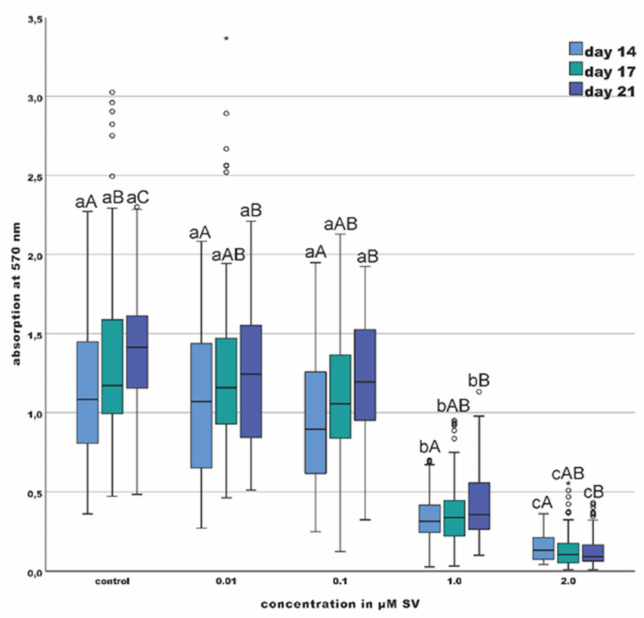
Figure 2. Viability given as photometric absorption at λ 570 nm of the MTT-assay; (di ff erent letters indicate statistically significant di ff erences at p < 0.05 within the day (capitalized) and concentration (uncapitalized)); (the upper and lower whiskers show the maximum and minimum values, the box represents 50% of the values and the horizontal line within the box displays the median